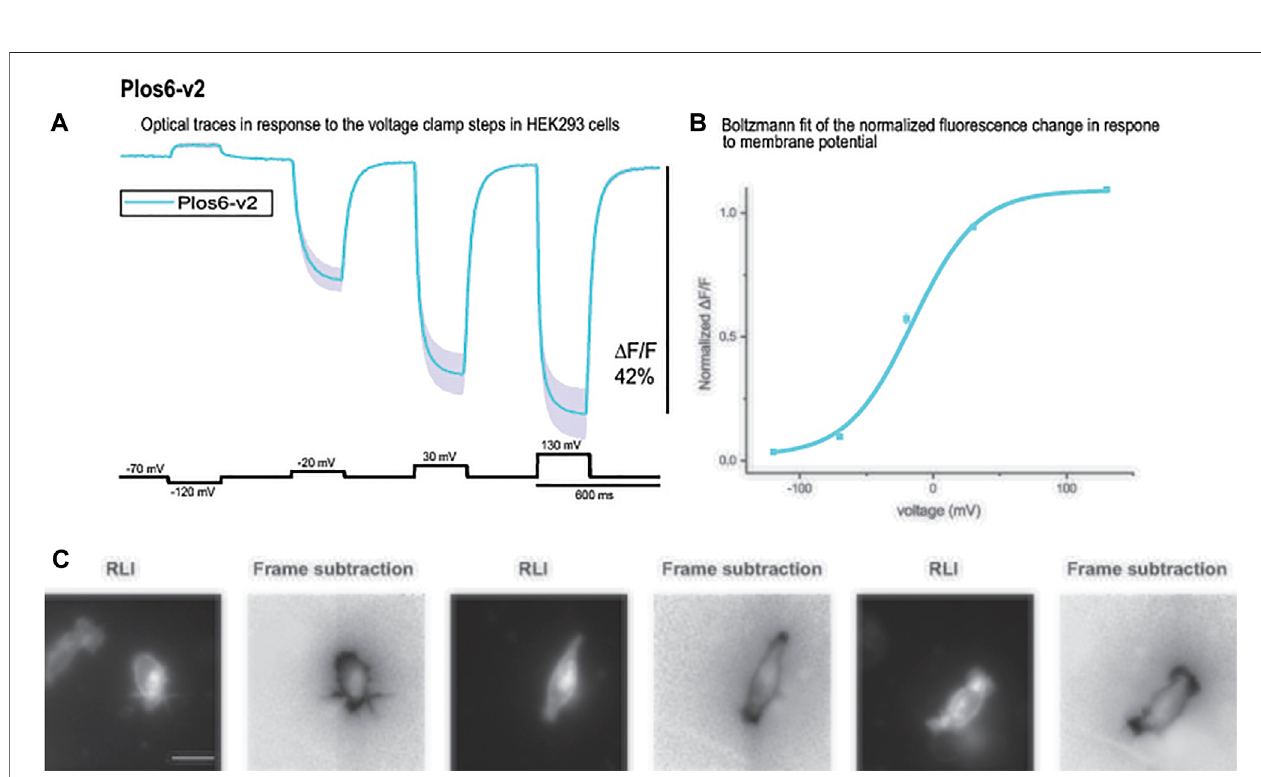
FIGURE 6 | The large fl uorescence response of Plos6-v2. (A) . Plos6-v2 was expressed in HEK-293 cells and subjected to whole cell voltage clamp. The dark line representstheaverageofthreecells.Theshadedregionisthestandarderrorofthemean. (B) .Plos6-v2Blotzmann fi tofthe fl uorescencechangeasafunctionofvoltage. (C) . Resting light images (RLI) and corresponding frame subtraction images of three cells expressing Plos6-v2. The fl uorescence average for each pixel from 20 frames during the 200 mV depolarization step were subtracted from the fl uorescence average of 20 frames at the beginning ofthe recording when the cells were held at a holding potential of − 70 mV. The scale bar represents 20 μ